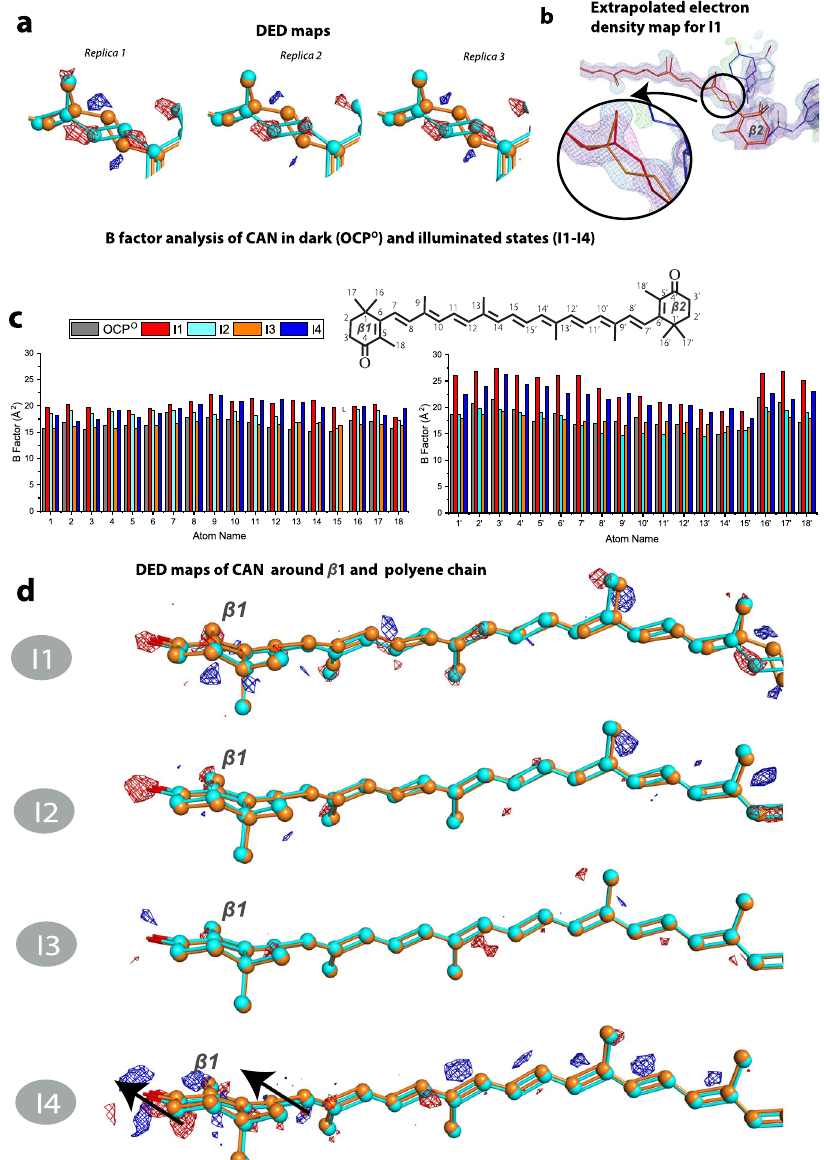
Fig. 4 | CAN conformation upon illumination. a Reproducibility of isomeriza- tion signal. Similar DED signals assigned to isomerization were observed for three different I1 datasets. b Extrapolated maps and coordinates of